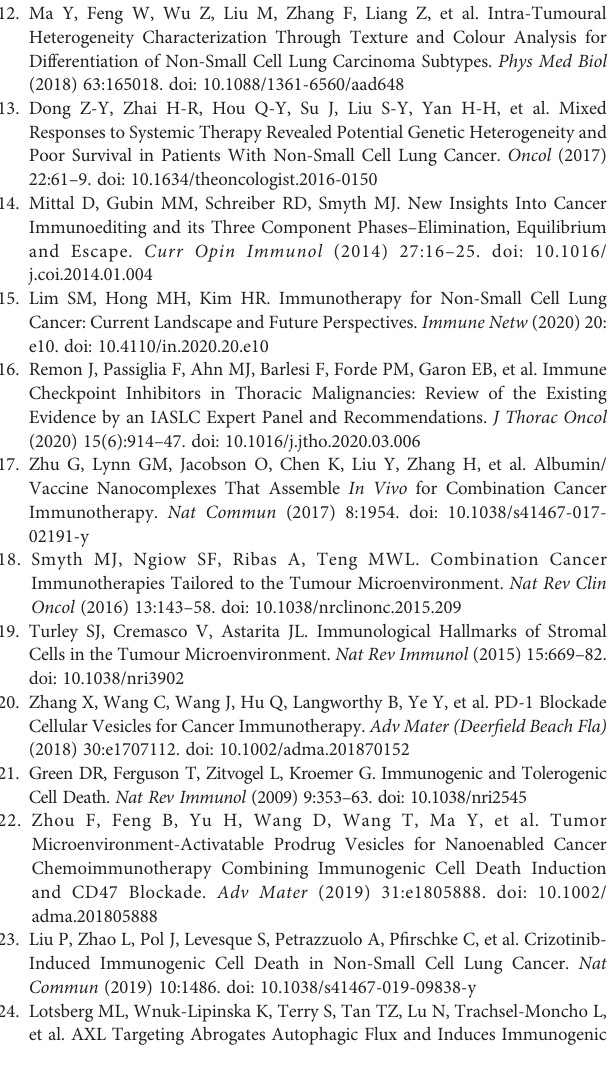
coding genes of SCC patients. (E) The PCA based on immune-related genes of SCC patients. (F) The PCA based on immune-related lncRNAs of SCC patients. Supplementary Figure 2 | Clinical correlation analysis between expression of LncRNA and prognostic factors of SCC patients: Age (A) , Gender (B) , Stage (C) , T (D) , N (E) , M (F) . The “ * ” means that p<0.05. The “ ** ” means that p<0.01. The “ *** ” means that p<0.001. Supplementary Figure 3 | Sankey diagram to show the correlation ship between model lncRNAs and immune related genes in SCC patients. Supplementary Figure 4 | Sankey diagram to show the correlation ship between immune related genes and model lncRNAs except Linc00996 in AD patients. Supplementary Figure 5 | Potential immune-related targets from TCPA (green round rectangle) and TCGA (orange ellipse) database of Linc0996 (blue ellipse). Supplementary Figure 6 | PCR validated the achievement of LINC00996 and AP001189.3 transfection. Supplementary Figure 7 | The insigni fi cant prediction result of ICI treatment between AD patients in high- and low-risk